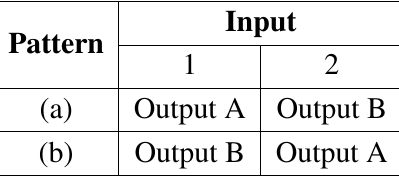
Figure 7. Output voltage waveforms of the power router at the instant of switching.